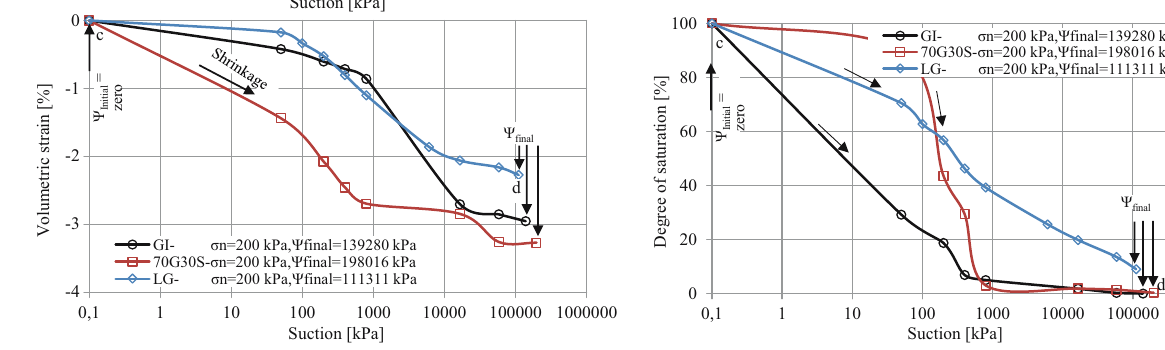
Figure 10: Variation of volumetric strain with suction of the ( CN - SI ) drying test.